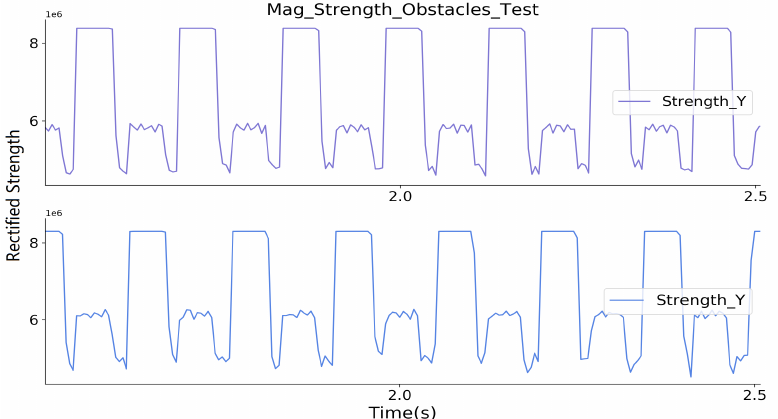
Figure 13. Close look of the received strength signals from both